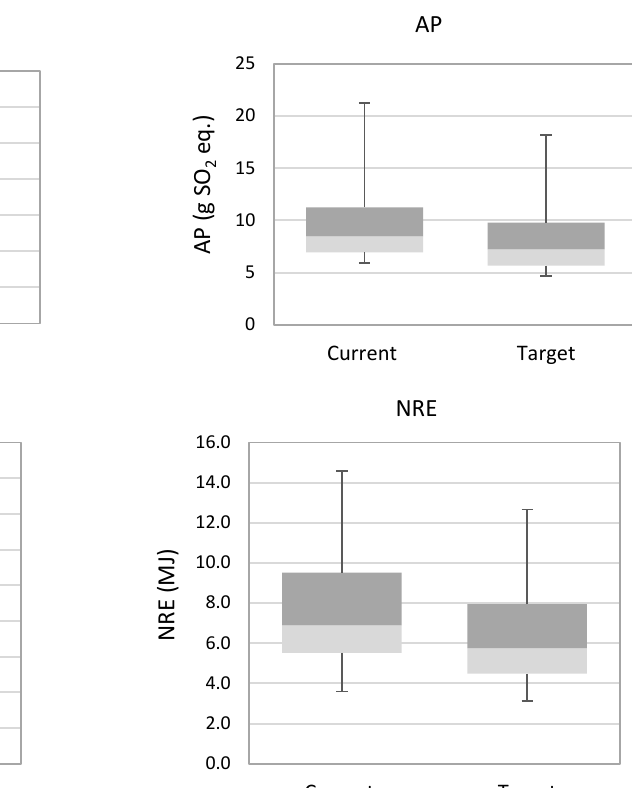
Figure 4. Distribution of environmental impacts of inefficient farms in the current and target situations for 1 kg wheat production.